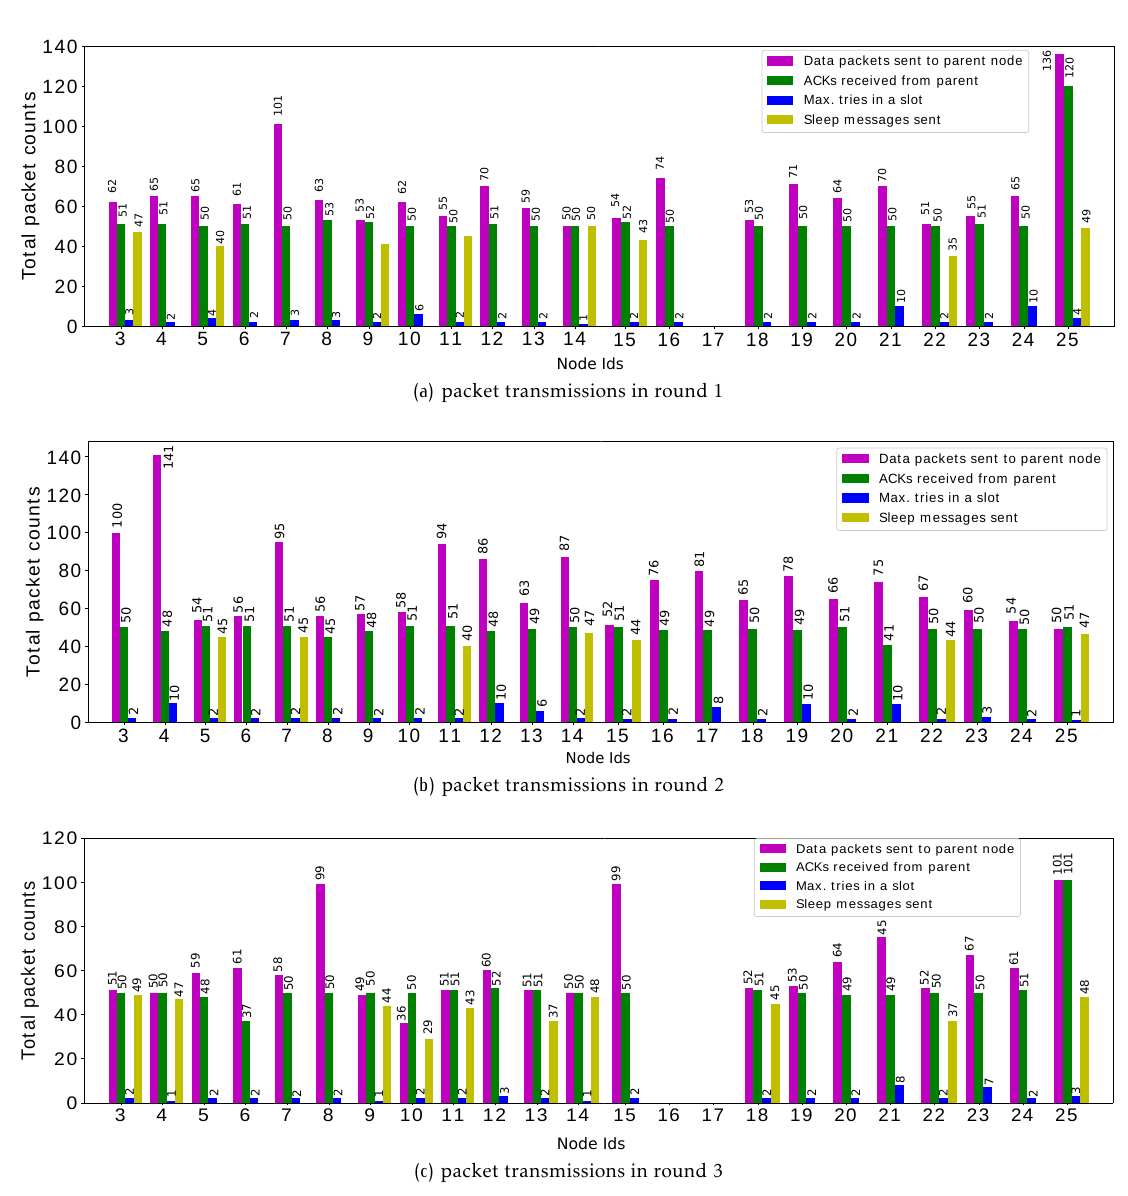
Figure 20. Comprehensive packet analysis from the snooper nodes for test case